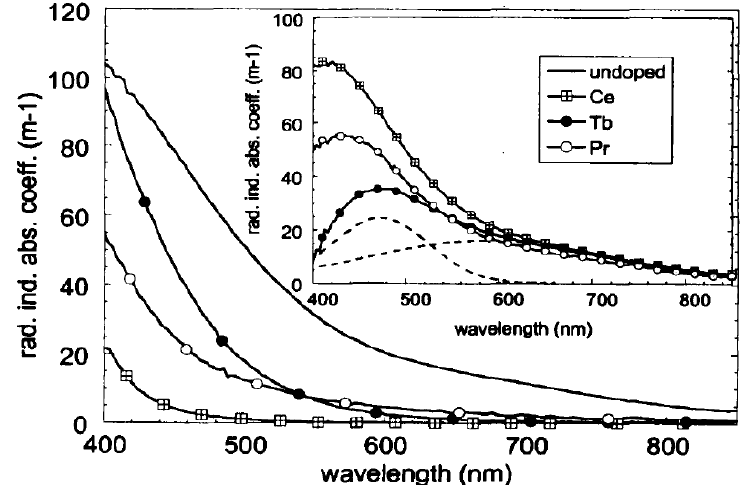
Figure 9. Radiation-induced color center distribution in all glasses after the highest irradiation dose. Inset: radiation-induced absorption bands “removed” by the trivalent doping and the Gaussian fit curves related to terbium doped glass (dashed lines). Reproduced from [80]. Copyrights Taylor & Francis 2003.